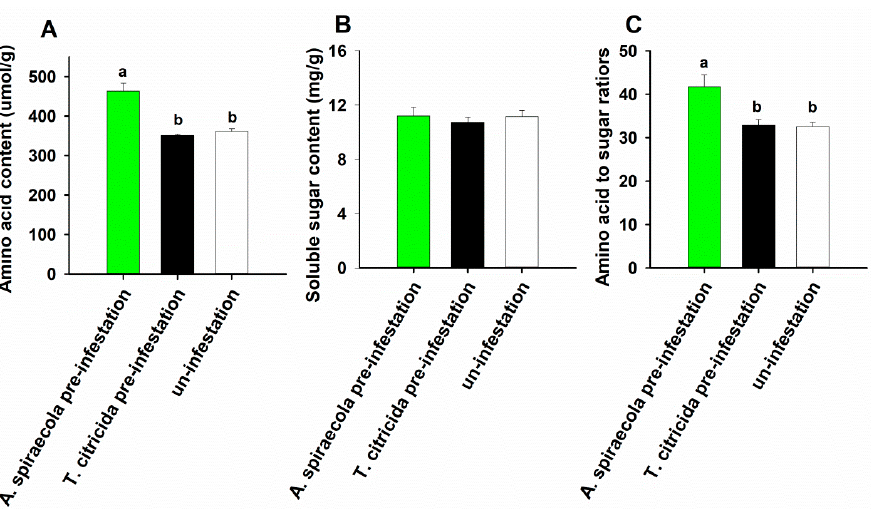
Figure 4. Amino acid concentration ( A ), soluble sugar concentration ( B ), and amino acid to sugar ratios ( C ) in sweet orange leaves pre-infested by A. spiraecola , T. citricida , or without aphid pre-infestation. Values represent the mean ± SE (Tukey’s HSD test, n = 5). Bars with di ff erent letters represent significant difference ( p < 0.05). Bars without letters indicate there is no significant di ff erence between treatments.